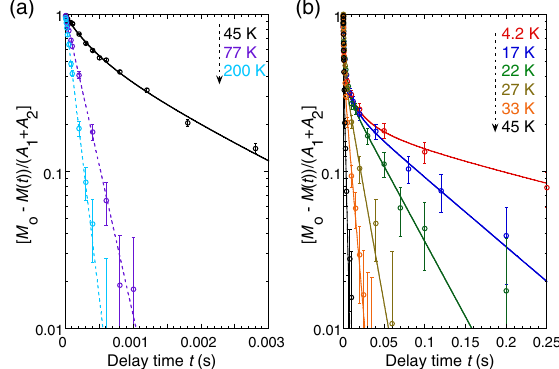
FIG. 14. (a),(b) Solid curves represent the two-component fit with Eq. (A3) above (a) and below (b) 45 K, presented in the form of ½ M o − M ð t Þ(cid:4) = ð A 1 þ A 2 Þ . Notice that after the initial quick decay caused by 1 =T 1 ; , there is a long, straight tail fast associated with the slow component 1 =T 1 ; . Dashed straight slow lines through the 77 and 200 K data points are the best exponential fit with Eq. (A1).